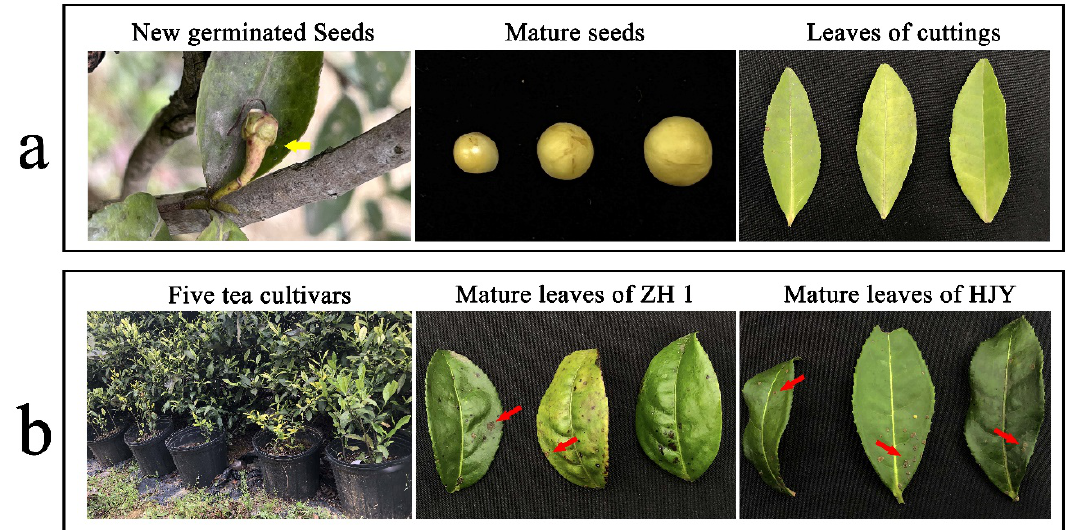
Figure 1. Transmission and infectivity of TPNRBV. ( a ) Phenotype of seeds and leaves of cuttings derived from TPNRBV-infected ‘BY 1’. ( b ) Five tea cultivars exposed to TPNRBV-infected ‘BY 1’ gardens for one year. Red arrows indicate necrotic ring blotch symptom.